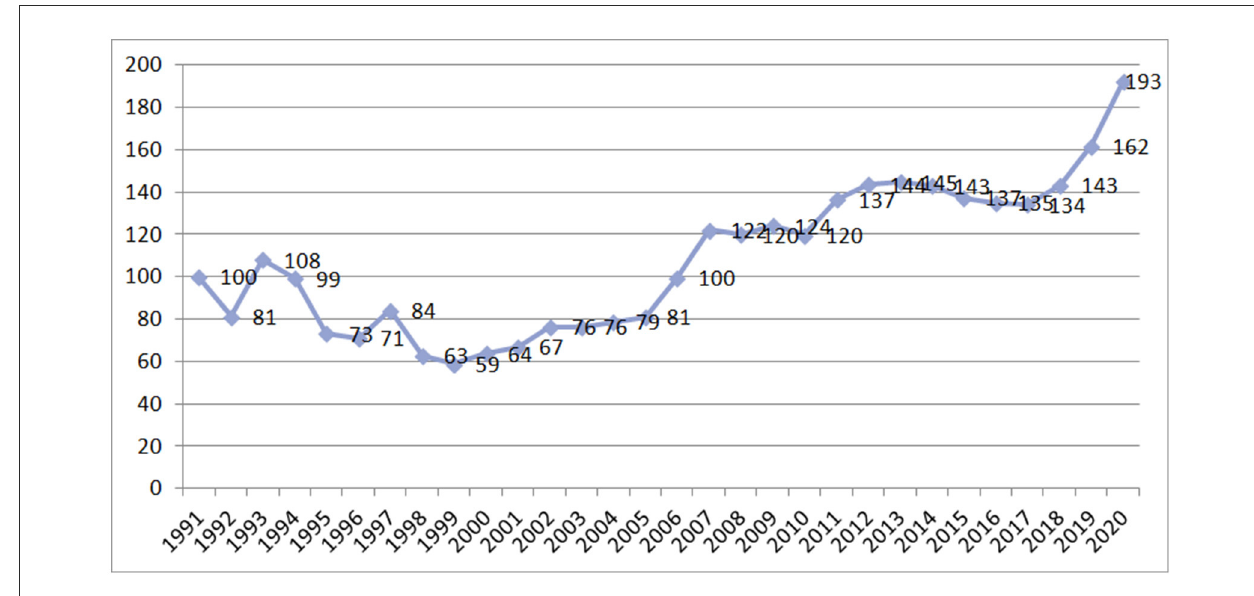
FIGURE2 Public funding of health care at constant prices in Russia in 1991–2020. Source : Authors’ estimates based on official data.